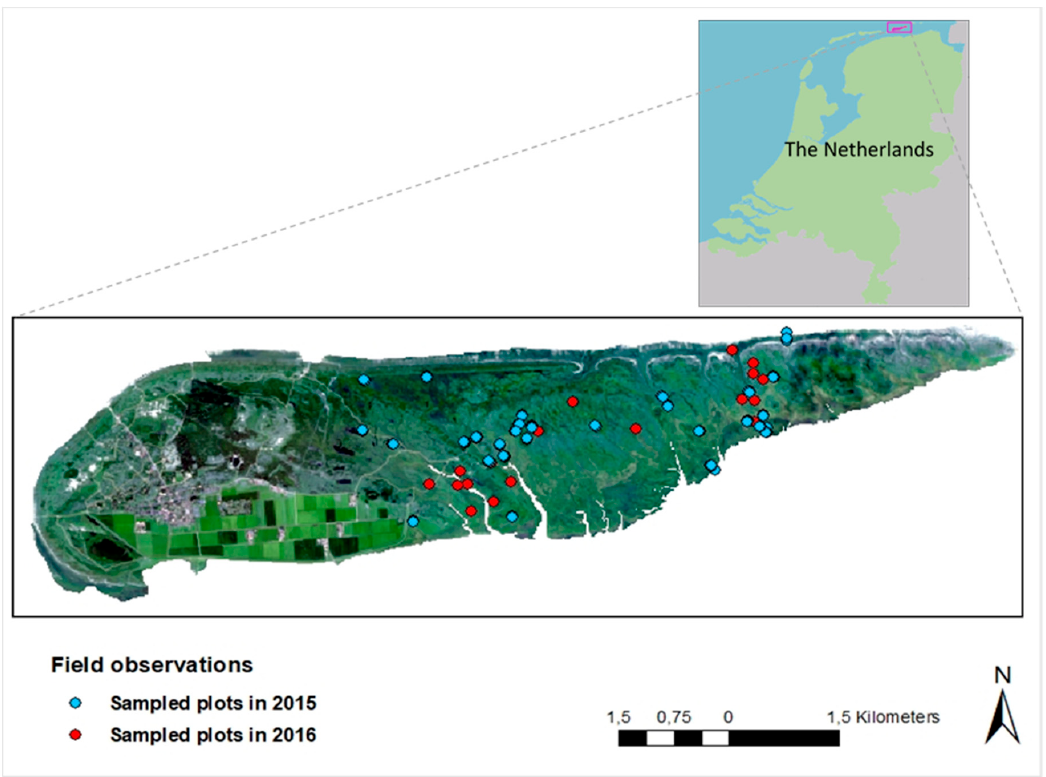
Figure 1. True colour composite of the Sentinel 2A image acquired on 30 July 2016 (bands 665, 560 and 490 nm) and the location of the study area (Schiermonnikoog Island, The Netherlands). The blue and red points demonstrate the distribution of sample plots in 2015 and 2016, respectively. Remote Sens. 2019 , 11 , x FOR PEER REVIEW